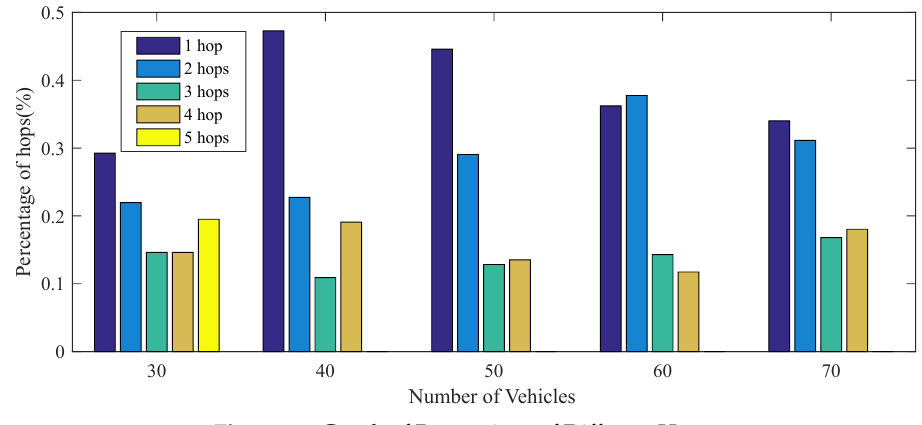
Figure 12. Graph of Proportions of Different Hops.